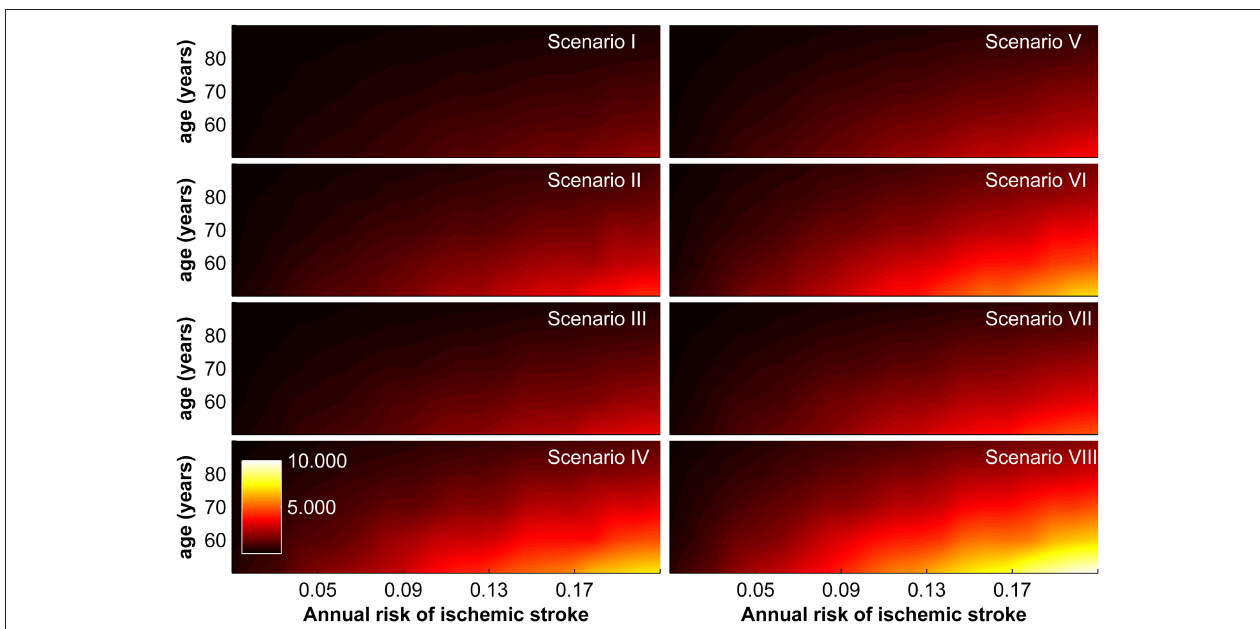
FIGURE 3 | Maximally allowable annual cost of device according to age and annual risk of ischaemic stroke for socio-geographic scenarios I–VIII. For a definition of socio-geographic scenarios, see main text and Table 7 .